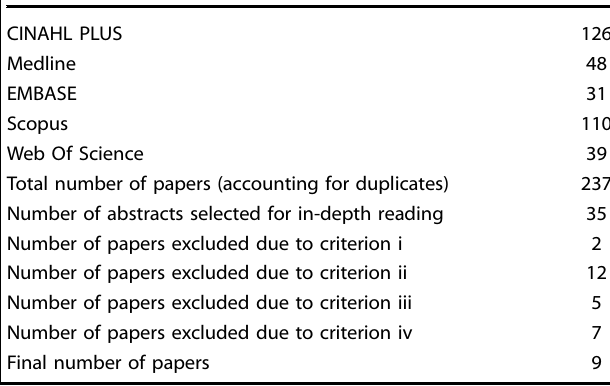
Table 3. Number of articles returned by database and subsequent